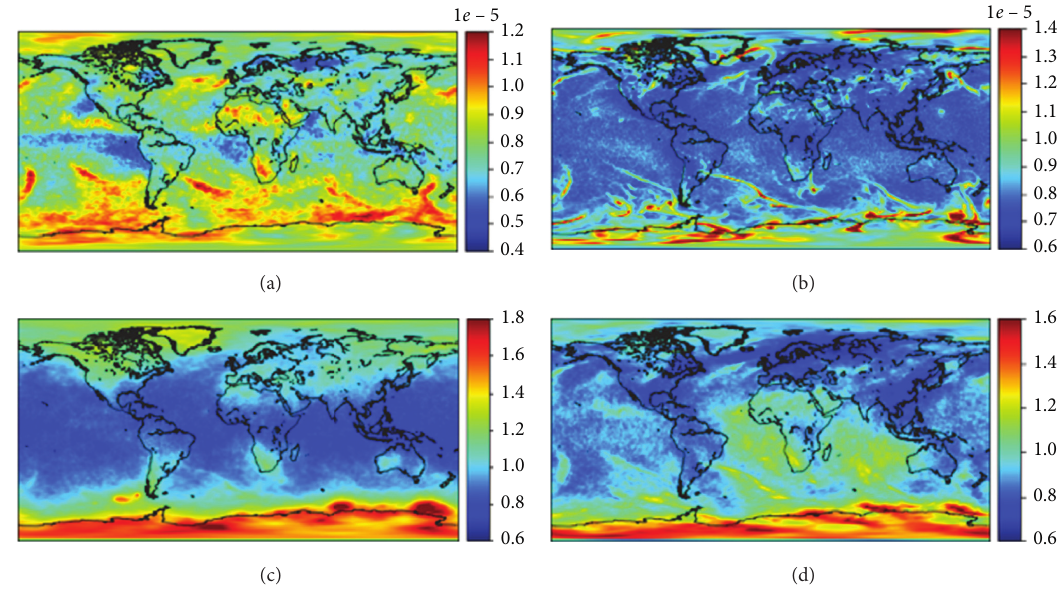
Figure 3: (a) Vorticity, (b) divergence, (c) temperature, and (d) U -wind standard deviation field at 1000hPa.